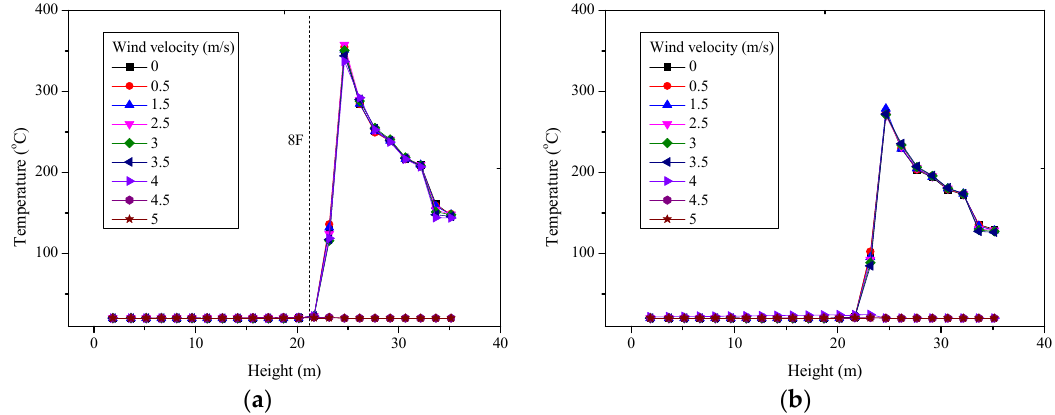
Figure 11. Vertical temperature distributions in the staircase under different wind velocities: ( a ) 4 MW and ( b ) 3 MW.